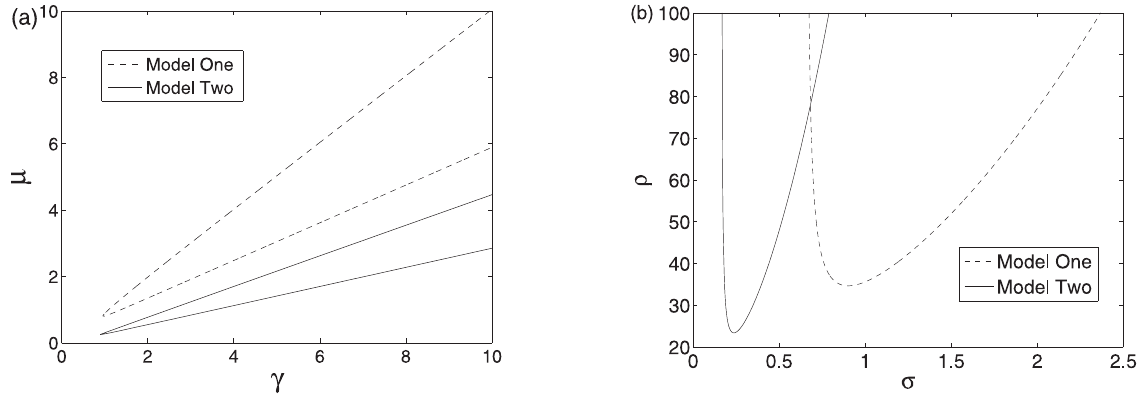
Figure 6. Bifurcation diagrams of the two systems. (a) The bifurcation diagrams with c and m as control parameters. (b) The bifurcation diagrams with s and r as control parameters. The regions enclosed by dashed and solid lines are the oscillatory regions of the two systems. Other parameter values are s ~ 0 : 4 , l ~ 0 : 3 , d ~ 0 : 5 , a ~ 2 , b ~ 0 : 2 , and r ~ 40 .